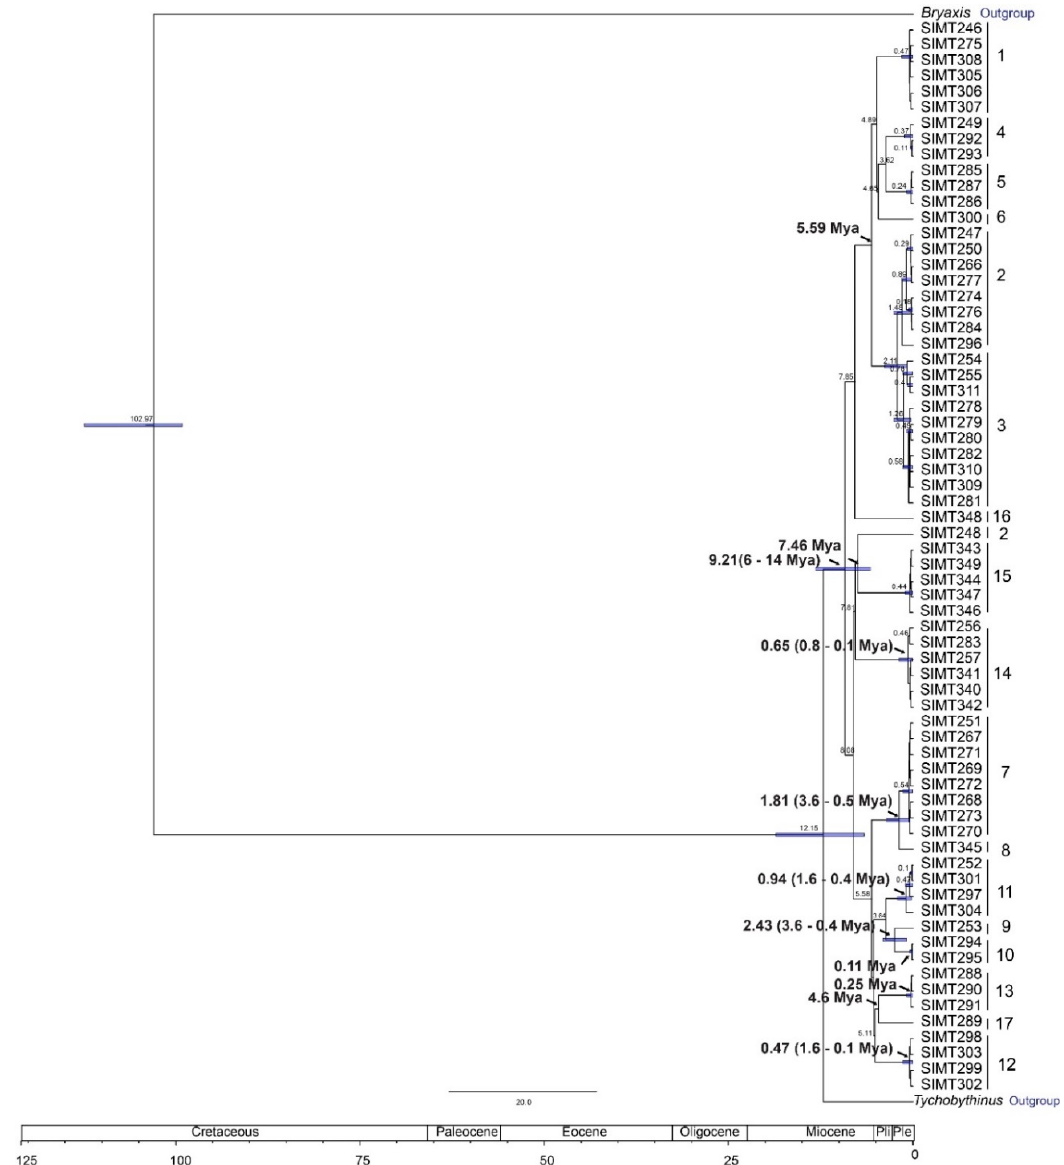
Figure 7. Divergence time estimation for Panabachia based on a relaxed molecular clock, using a combined data set.